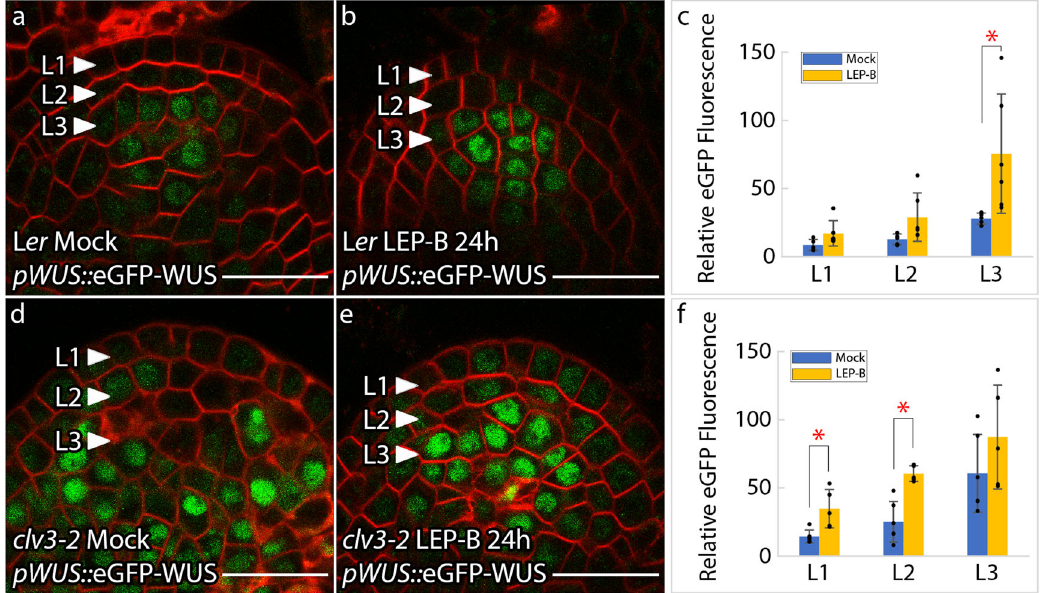
Fig. 4 Stable nuclear accumulation of the WUS protein ( pWUS:: eGFP-WUS) in the L1 layer of clv3-2 mutants upon Leptomycin-B treatments. a , b Wild- type plants with pWUS:: eGFP-WUS reporter in response to a mock ( n = 5) or b 20 nM LEP-B ( n = 6) treatments. c Quanti fi cation of pWUS:: eGFP-WUS fl uorescence levels (mean ± s.d.) from treatments shown in a , b . The “ n ” represents the number of independently treated plants. d , e clv3-2 mutant plants with pWUS:: eGFP-WUS reporter in response to d mock ( n = 6) or e 20 nM LEP-B ( n = 5) treatments for 24 h. f Quanti fi cation of pWUS:: eGFP-WUS fl uorescence levels (mean ± s.d.) from treatments shown in d , e . The “ n ” represents the number of independently treated plants. The * represents a p value ≤ 0.05 when compared to WUS levels from mock treatments in the same cell layer (Student ’ s two-tailed t- test). Error bars represent the standard deviation. eGFP (green) is overlaid on FM4-64 (Red) plasma membrane stain. Scale bars = 20 μ